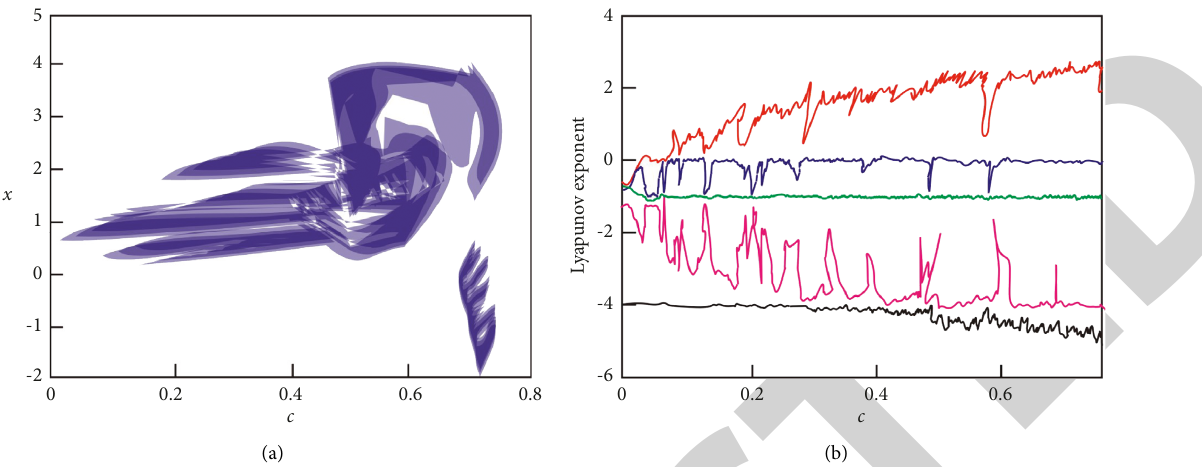
Figure 4: The system shows the branch diagram and Lyapunov index spectrum that vary according to parameter c : (a) bifurcation graph and (b) Lyapunov exponent spectrum of the system with the parameter c .